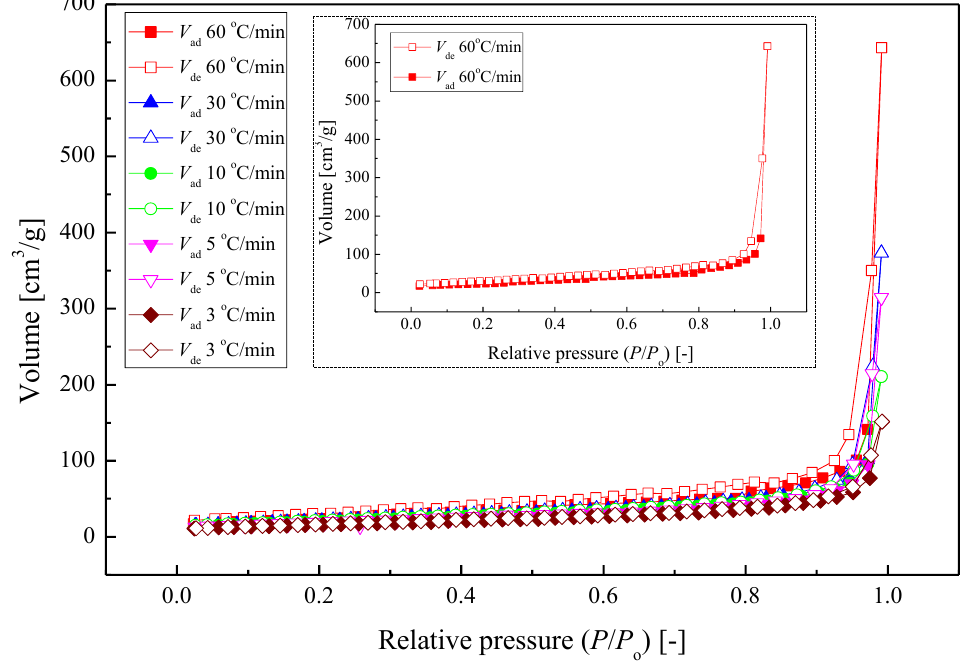
Figure 6. Nitrogen adsorption–desorption isotherms of the Ag–TiO 2 nanocomposite films annealed at 600 ºC with heating rates of 3-60 ºC/min.